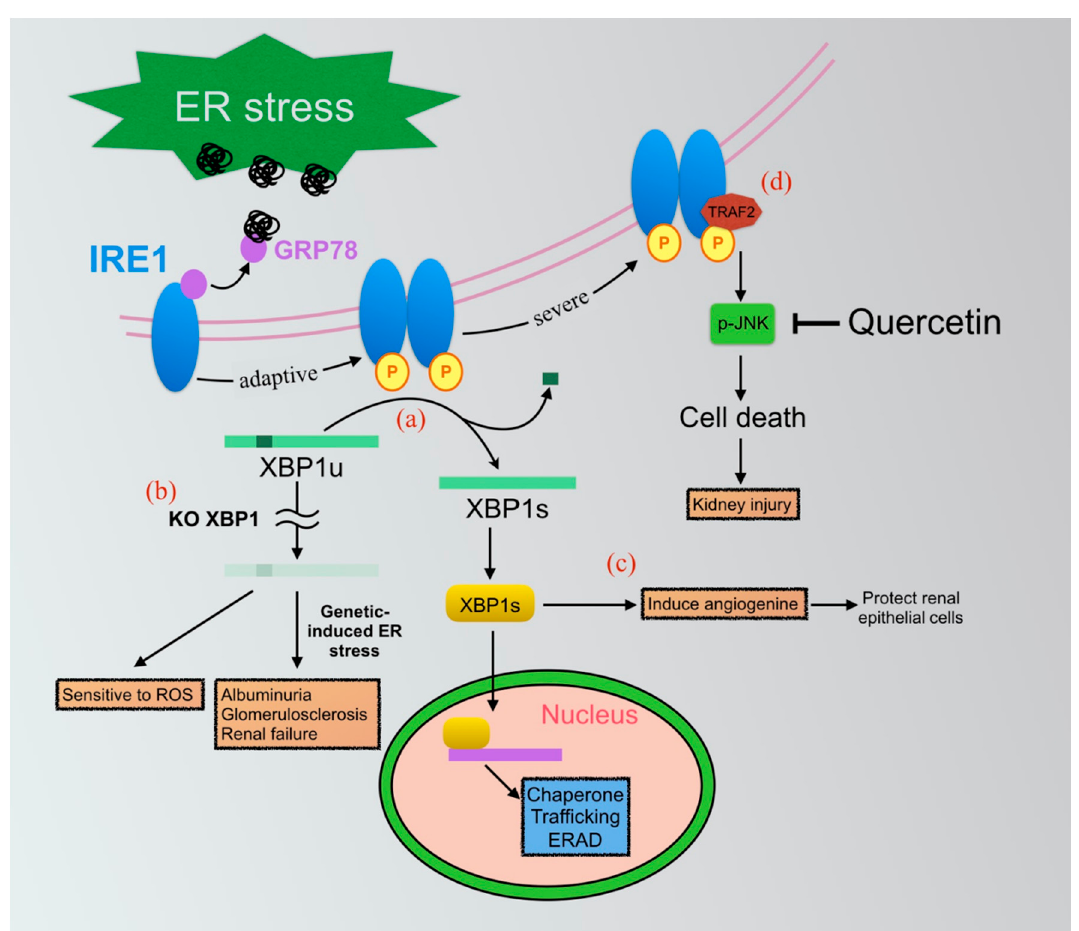
Figure 1. The IRE1-XBP1-related UPRs pathways played pathological and therapeutic roles in kidney disease. ( a ) Unfolded proteins bind to BiP and allow the activation of IRE1 to occur through its dimerization and trans-autophosphorylation. IRE1 phosphorylation as indicated p in the yellow cycle. Activated IRE1 splices the mRNA of XBP1u to form spliced XBP1 (XBP1s) mRNA, which encodes XBP1s protein then translocates to the nucleus, inducing genes that are thought to be generally cytoprotective, such as chaperones, trafficking associators, ERAD-related proteins. ( b ) Evidence shows that XBP1 knockout makes cells sensitive to oxidative stress, an important insult to kidney injury. Combining the XBP1 knockout model with genetically induced ER stress in the kidney leads to severe albuminuria, glomerulosclerosis, and renal failure. ( c ) XBP1s could directly induce angiogenin (ANG) expression in renal epithelial cells, which has been proven to protect cells and attenuate adverse effects caused by ER stress. ( d ) Severe ER stress triggers cell death through the IRE1-TRAF2-JNK pathway in many kinds of kidney diseases. Quercetin, a natural flavonoid, has been demonstrated to inhibit the IRE1-TRAF2-JNK pathway in unilateral ureteral obstruction (UUO), diabetic nephropathy, and cadmium-induced kidney injury. It might be a strong therapeutic option for the targeting of UPRs.